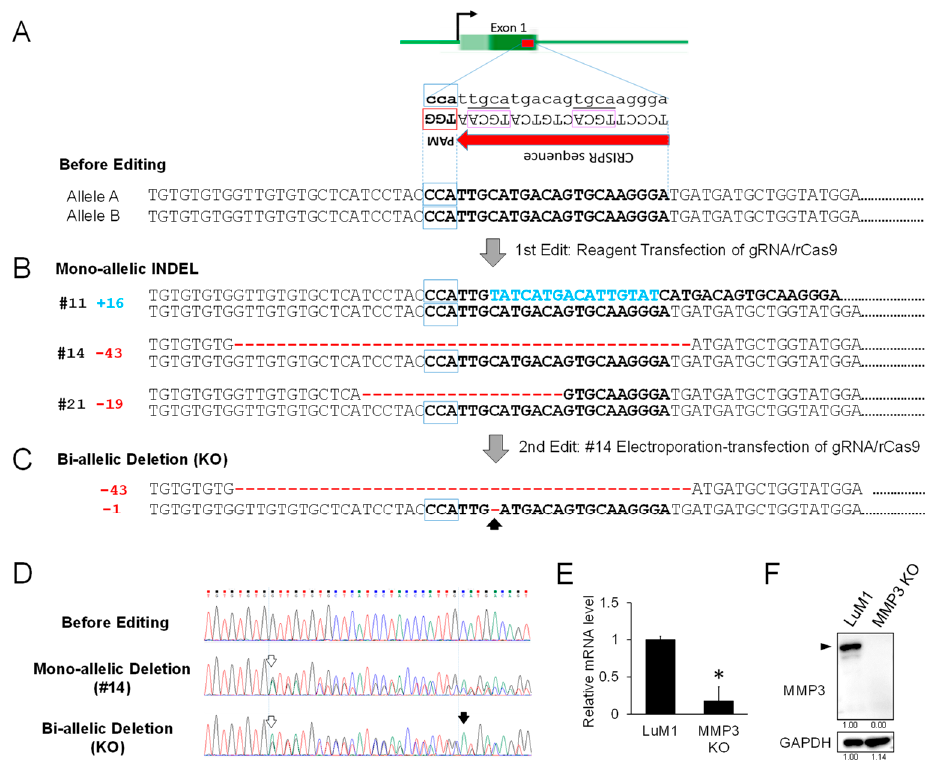
Figure 3. Establishment of MMP3-KO cells using CRISPR / Cas9 genome editing technology. ( A ) Figure 3. Schemes representing the targeting of exon 1 in the Mmp3 gene. Top, a scheme of Mmp3 gene. Dark green box, a coding region of exon 1 including the target sequence. Bright green box, 5 (cid:48) -untranslated region. Middle, a CRISPR sequence containing 5 (cid:48) -TGCA-3 (cid:48) repeat enclosed with purple square, tailed with PAM sequence (TGG) in the antisense strand. Bottom, a partial sequence of Mmp3 exon 1 including the target sequence (shown in bold). ( B ) The sequences of mono-allelic INDEL clones. Three types of mono-allelic INDEL clones were obtained. Clone #11 contained a 16-bp insertion sequence, shown in blue. Clones #14 and #21 conferred 43-bp and 19-bp deletions, respectively, shown in red. ( C ) DNA sequences of the bi-allelic deletion clone. This clone was obtained from the clone #14 with an additional single nucleotide deletion in the counterpart allele, as indicated by an arrow. ( D ) DNA sequences before editing, of mono-allelic deletion (#14 clone) and bi-allelic deletion (KO). White arrows, the position of the first deletion. Black arrow, the position of the single nucleotide deletion in the 2nd edit. ( E ) RT-qPCR analysis of Mmp3 mRNA in the parental LuM1 cells and the MMP3-KO cells. The mRNA level of Mmp3 was decreased while the mutant mRNA of Mmp3 was detectable. The relative mRNA levels were normalized to Gapdh , an internal control. * p < 0.05, n = 6. ( F ) Western blot showing MMP3 in the cell lysates. Arrowhead indicates full-length MMP3 (54 kD). The experiments were repeated thrice in Figure